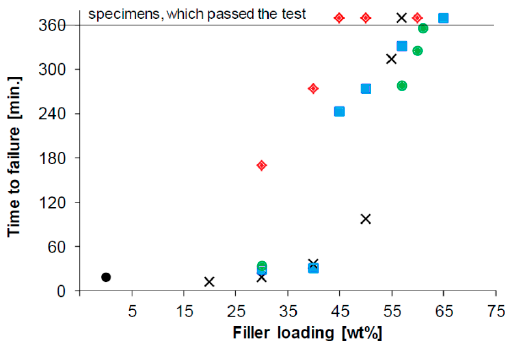
Figure 35. Average time to failure of composites material supplier (crosses), ground modified ATH of 3.5 µ m (squares), ground modified ATH of 3.5 µ m (diamonds) and surface modified ground SiO 2 particles (circles) in the inclined plane test (IPT) at 6 kV filled at different contents and compared